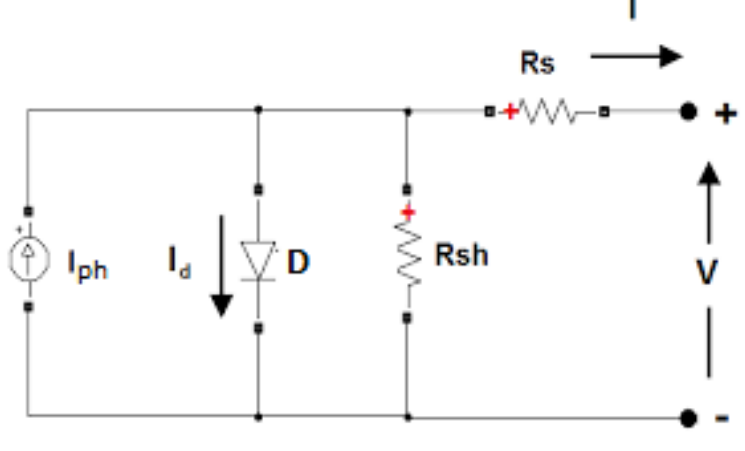
Figure 1. PV cell equivalent